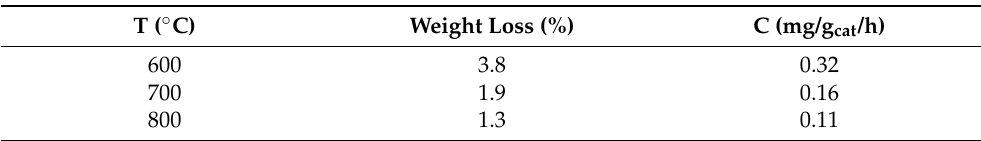
Table 6. The weight loss of Ni/CeZrO 2 samples and the rate of carbon deposition after stability